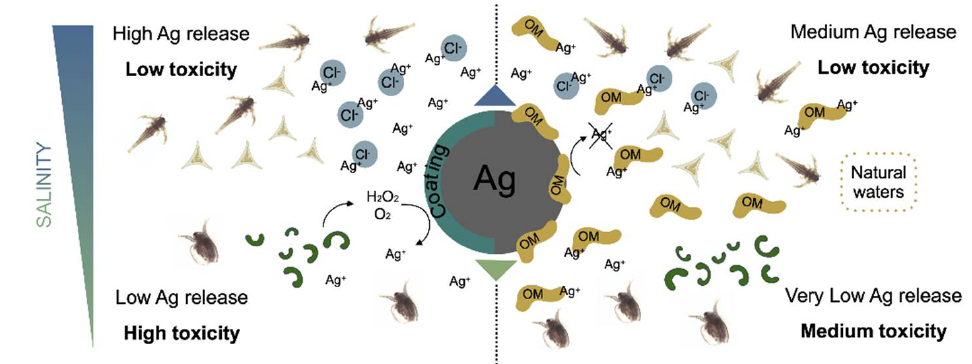
Figure 4. Release of Ag + ions from AgNPs and toxicity on aquatic plankton as influenced by environmental conditions and water chemistry (OM: Organic Matter). Not to scale.